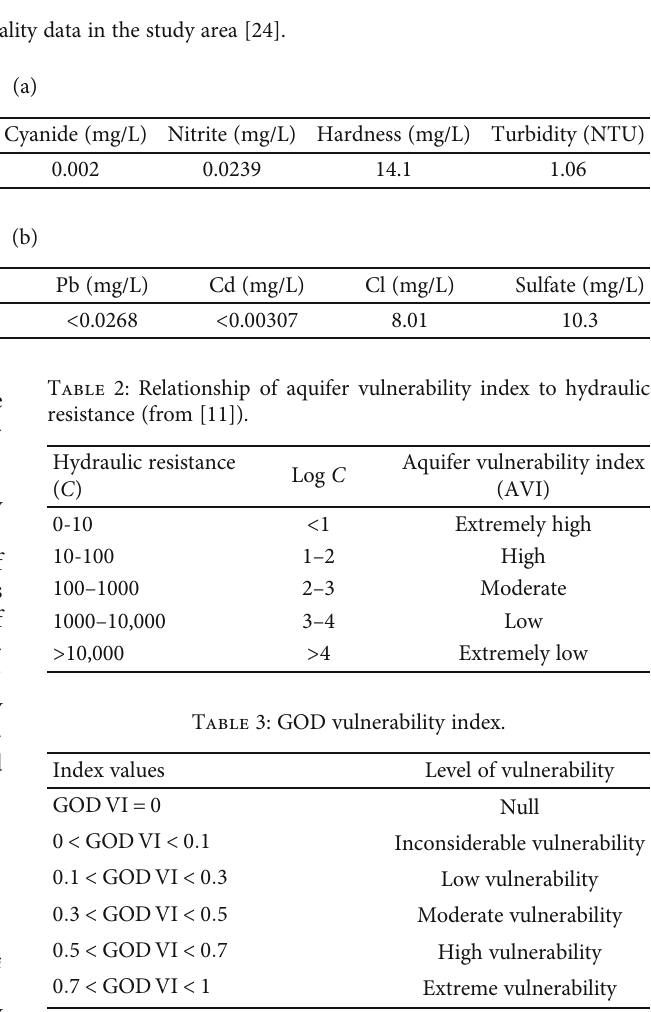
Table 1: Groundwater quality data in the study area [24].